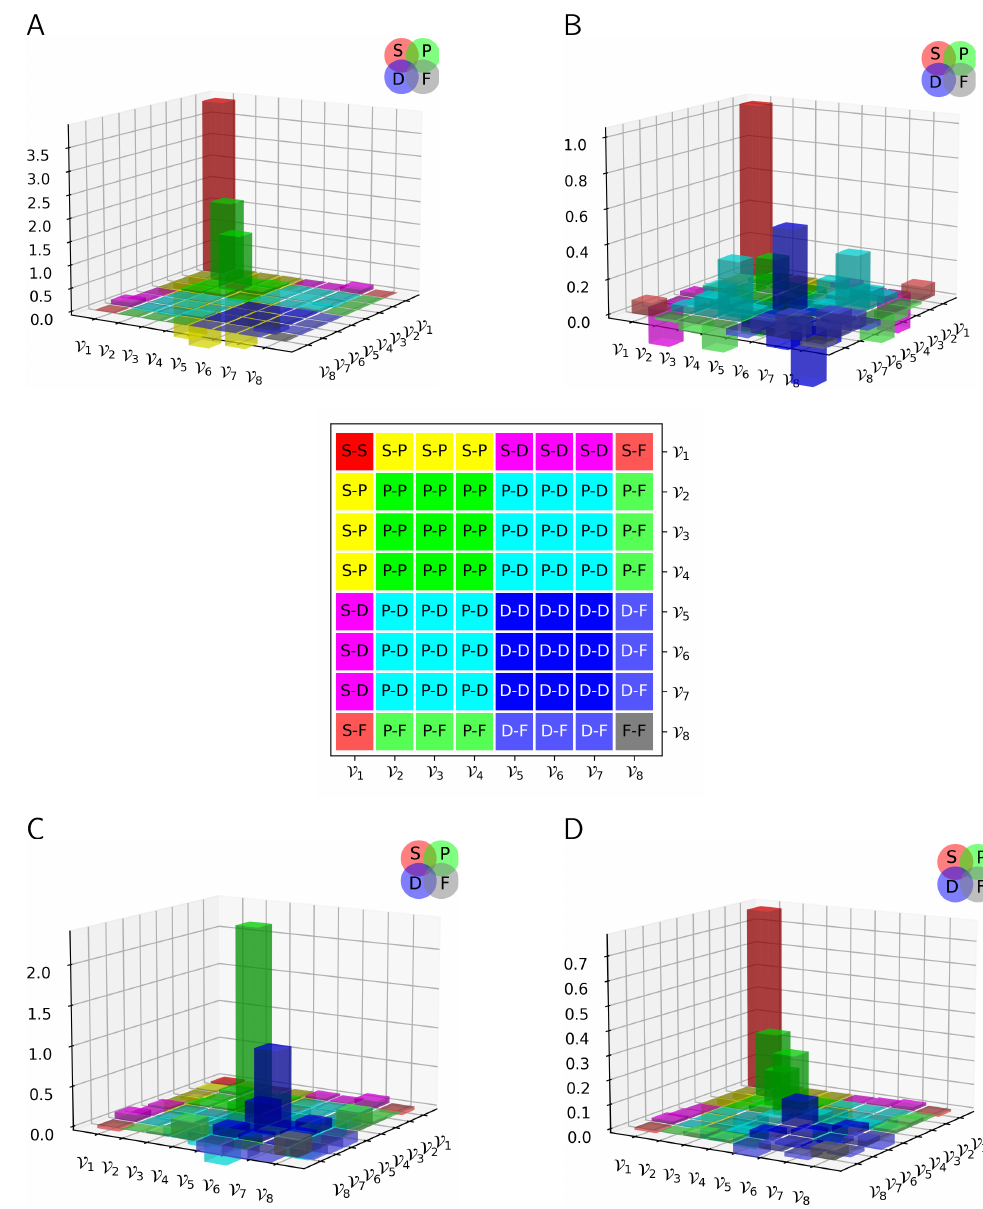
± ) , 3 2 2 + + − ; B ∆ ( 1600 ) 3 ; C ∆ ( 1700 ) 3 ; D 2 2 2